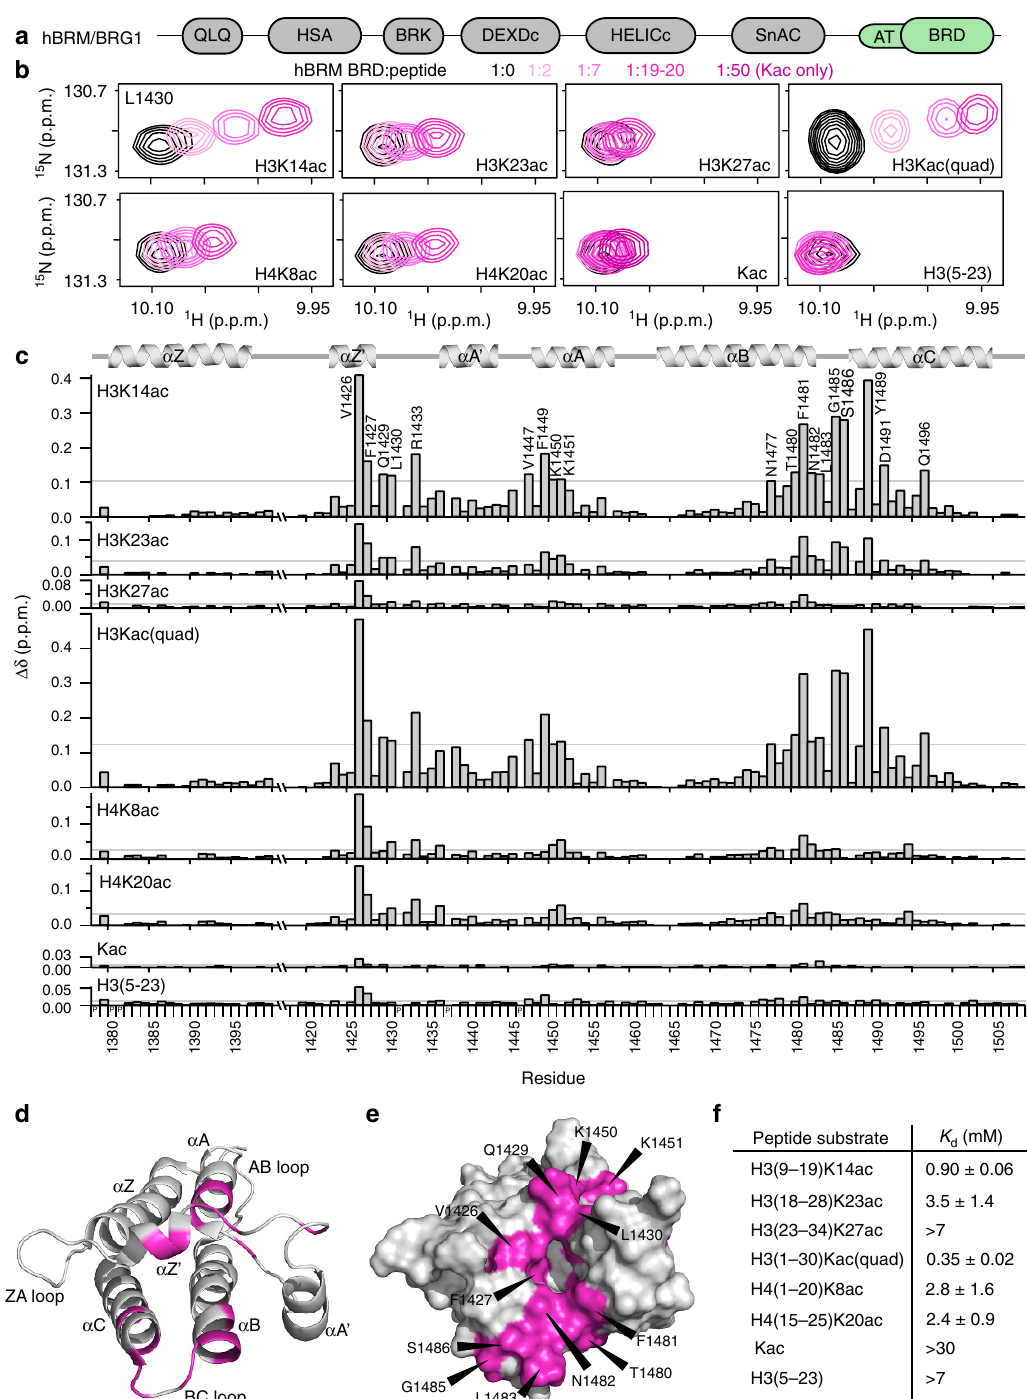
Figure 1 | The hBRM BRD binds acetylated histone tails weakly with specificity for H3K14ac. ( a ) The domain architecture of the hBRM and BRG1 ATPase subunits of the BAF complex. ( b ) Overlay of 1 H- 15 N HSQC spectra of 15 N-hBRM BRD upon titration of histone peptide. The selected region displays the resonance for L1430, and spectra are colour coded according to protein:peptide molar ratio as shown in the legend. Peptide titrations were collected at protein:peptide molar ratios of 1:0, 1:0.5, 1:1, 1:2, 1:4, 1:7, 1:12 and 1:19-20. The free acetyl-lysine titration included the additional 1:50 point. For clarity, only 4–5 points are displayed. ( c ) Corresponding normalized CSPs plotted as a function of residue for each histone peptide ligand shown in b for the protein:peptide molar ratio of 1:19–20. The secondary structure of the BRD is denoted above the plots, and residues that were perturbed greater than the average plus two standard deviations after trimming off the top 10% of CSPs are labelled for binding to H3K14ac. A grey line marks this level of significance for each titration. ( d , e ) Structure of the hBRM BRD (PDB ID 2DAT) in cartoon representation with the secondary structure elements labelled ( d ) and surface representation ( e ). Residues that are significantly perturbed upon binding to H3K14ac are coloured in pink and labelled. ( f ) Dissociation constants ( K d ) determined from NMR titrations with 15 N-hBRM BRD. K d values are fit to a single-site binding model under ligand-depleted conditions using 8–9 titration points. Shown are the averages over individual residues with significant CSPs (12–19 in total) and associated standard